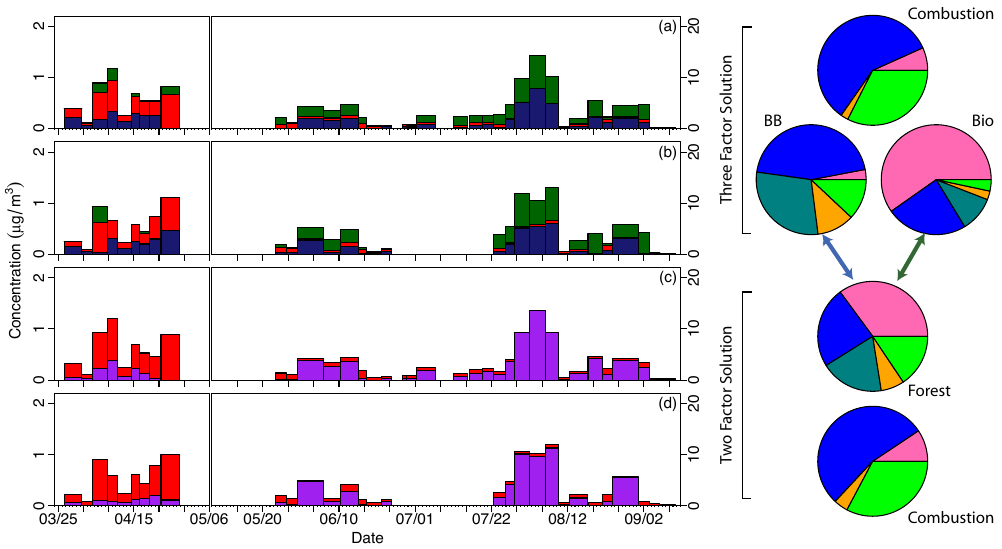
Fig. 11. Time series of submicron OM reconstructed from (a) day samples and (b) night samples for three-factor PMF with anthropogenic combustion factor (red), Factor Bio (dark green), and Factor BB (blue). Two-factor PMF solution is shown for (c) day samples and (d) night samples with anthropogenic combustion factor (red) and forest factor (purple). Note the different axis scale for the spring and summer periods. In the right panel, the OFG composition of the factors are represented with organic hydroxyl (pink), alkane (blue), ketone (teal), primary amine (orange), and acid (green) groups. Factor BB (left pie) and Factor Bio (right pie) from the three-factor solution are essentially a split of the forest factor from the two-factor